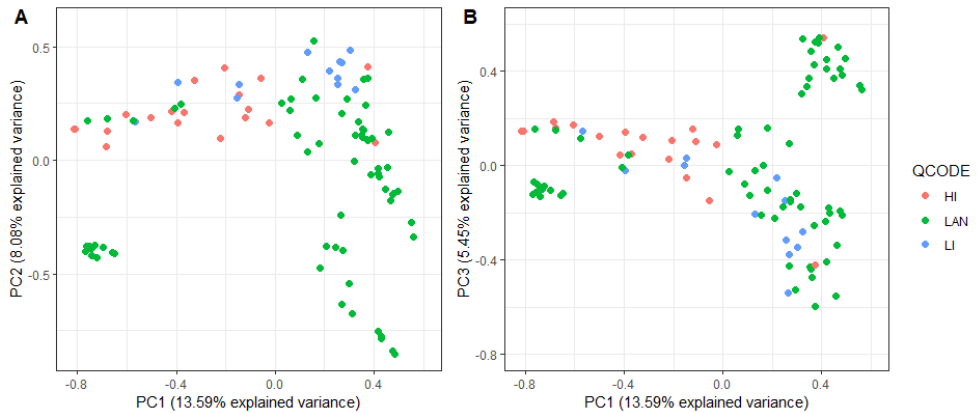
Figure 4. Principal component analysis of the kinship matrix visualizing the genetic relationships between 98 lines. The figure on the left ( A ) represents the first principal component (PC1; x-axis) and the second principal component (PC2; y-axis), and the figure on the right ( B ) represents PC1 (x-axis) and the third principal component (PC3; y-axis). In both plots, genotypes are coloured according to nursery type. LAN, landraces; HI, high-input breeding line (ZBS + ZIC); LI, low-input breeding line (ZBT).